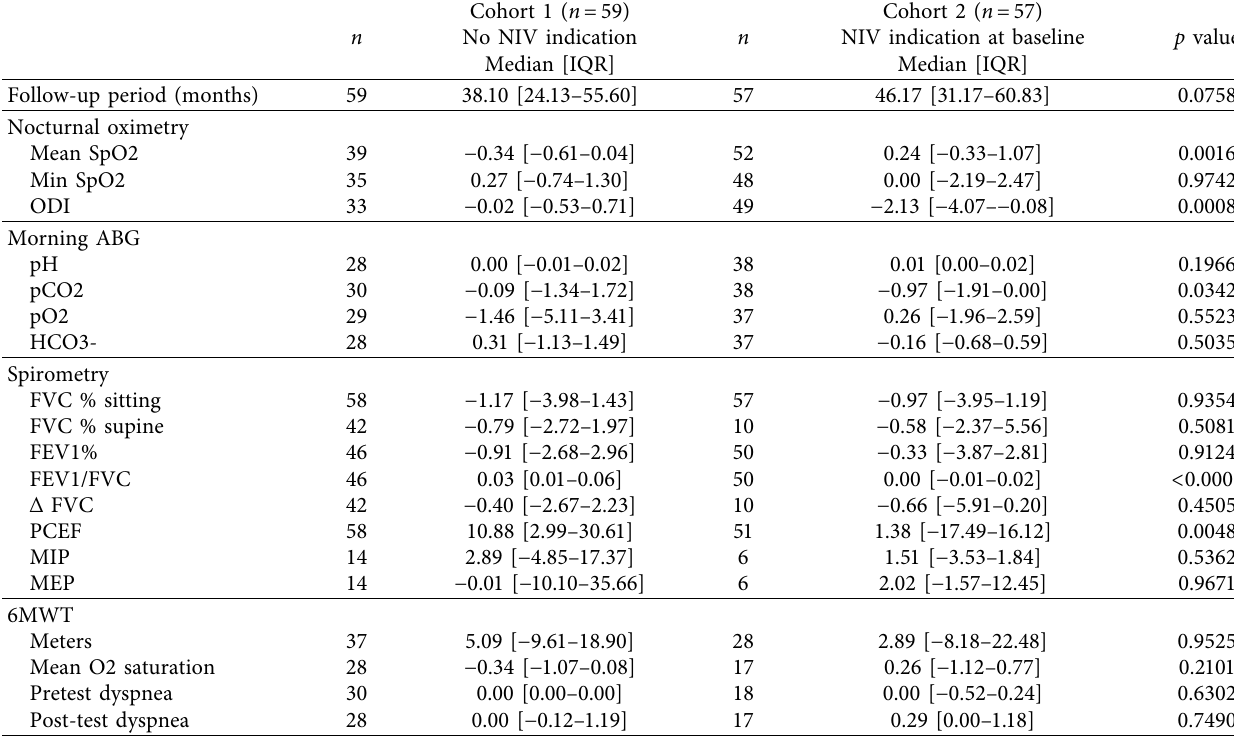
Table 6: Changes per year of the respiratory parameters in the 2 cohorts according to NIV